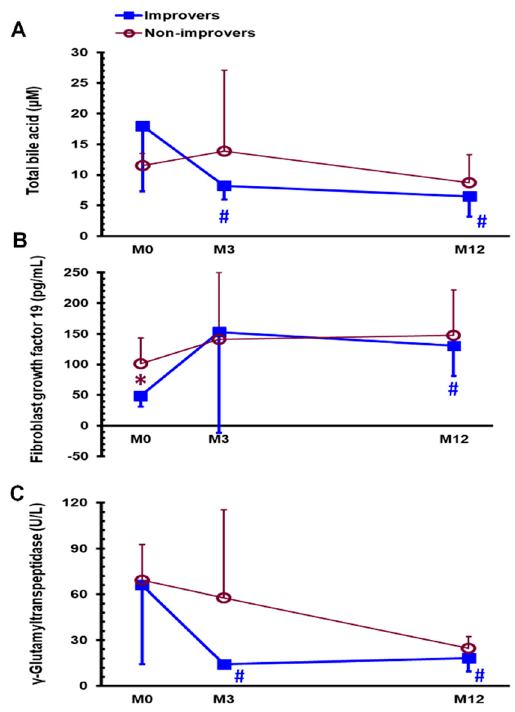
Figure 4. Serumlevelsoftotalbileacid( A )andfibroblastgrowthfactor19( B )and γ -glutamyltranspeptidase Figure 4. Serum levels of total bile acid ( A ) and fibroblast growth factor 19 ( B ) and γ - ( C ) in the FL-I and FL-non-I groups before (M0) and 3 months (M3) and 1 year (M12) after sleeve gastrectomy. glutamyltranspeptidase ( C ) in the FL-I and FL-non-I groups before (M0) and 3 months (M3) and 1 * p < 0.05 compared between FL-I and FL-non-I groups, # p < 0.05 compared with MFL-I, improvers of fatty year (M12) after sleeve gastrectomy. * p < 0.05 compared between FL-I and FL-non-I groups, # p < 0.05 liver; FL-non-I, non-improvers of fatty